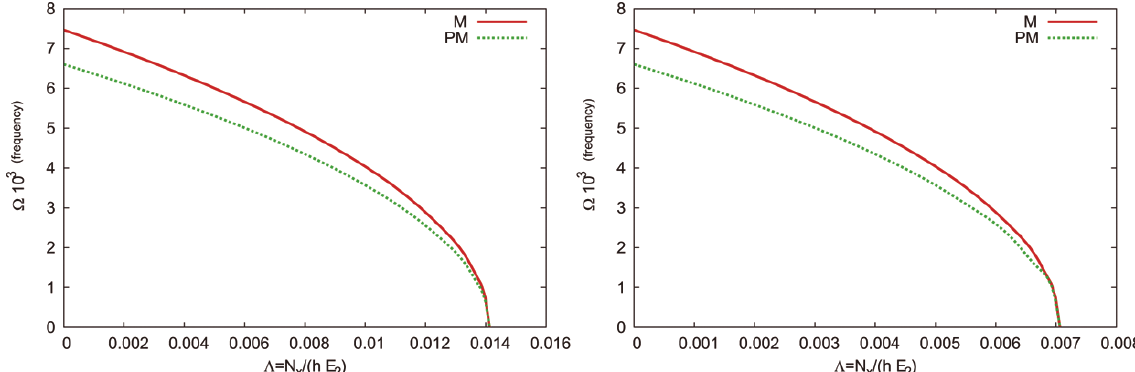
Fig. 9. M = [11], PM = Presented Model. UAC (left) and BAC (right) for a SSSS plate. PLATE-41, Mesh 10 × 10 , a/h = 50 .